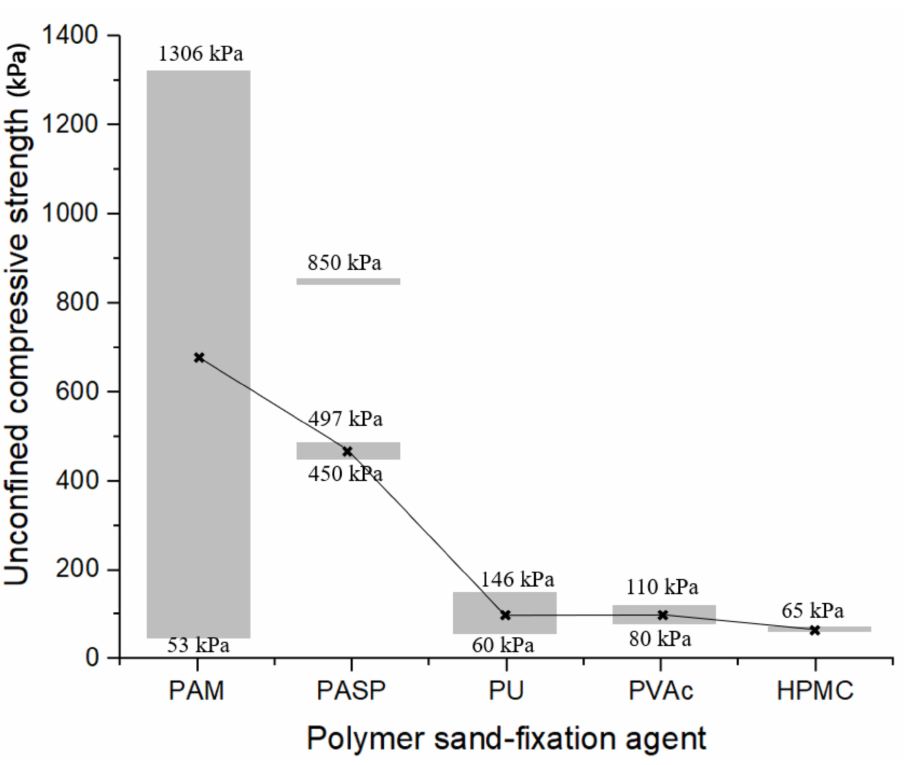
Figure 5. Unconfined compressive strength of sand-fixation agent (These marks are the midpoints of the values and connect them with